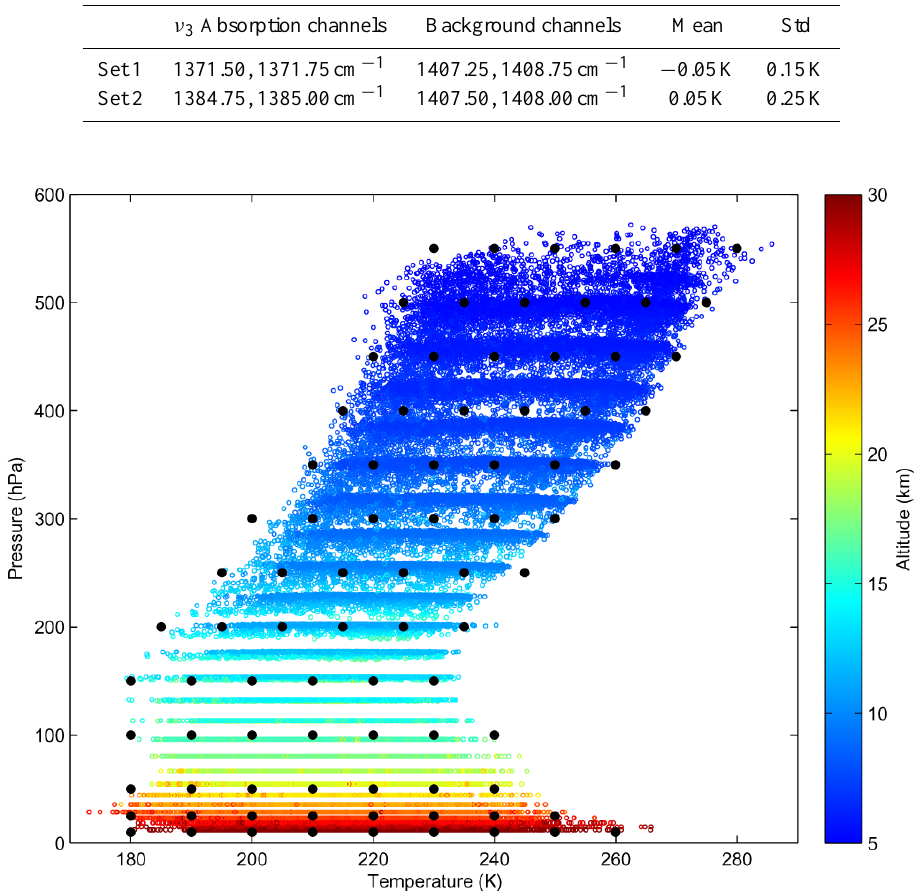
Fig. 4. Pressure and temperature correlations of the ERA-40 data set between 5 and 30km. The black dots are the PT pairs for which the lookup tables were